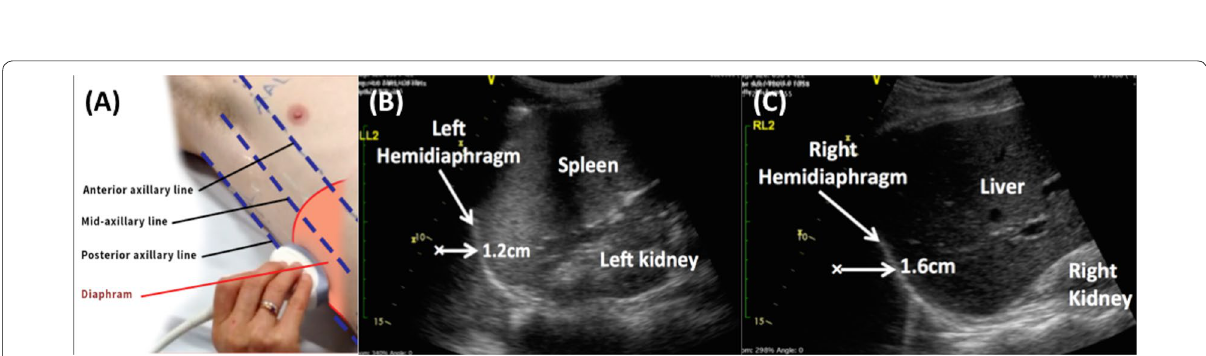
Fig. 7 Ultrasound technique and images of the diaphragm. A The location of probe placement on the chest wall for assessment of diaphragm movement. The probe is placed laterally and perpendicularly on the lateral chest wall on the lower intercostal spaces between mid- and posterior axillary line. B , C The ultrasound images of the left and the right hemidiaphragm and the measurement of the diaphragmatic excursion from end of end inspiration to end